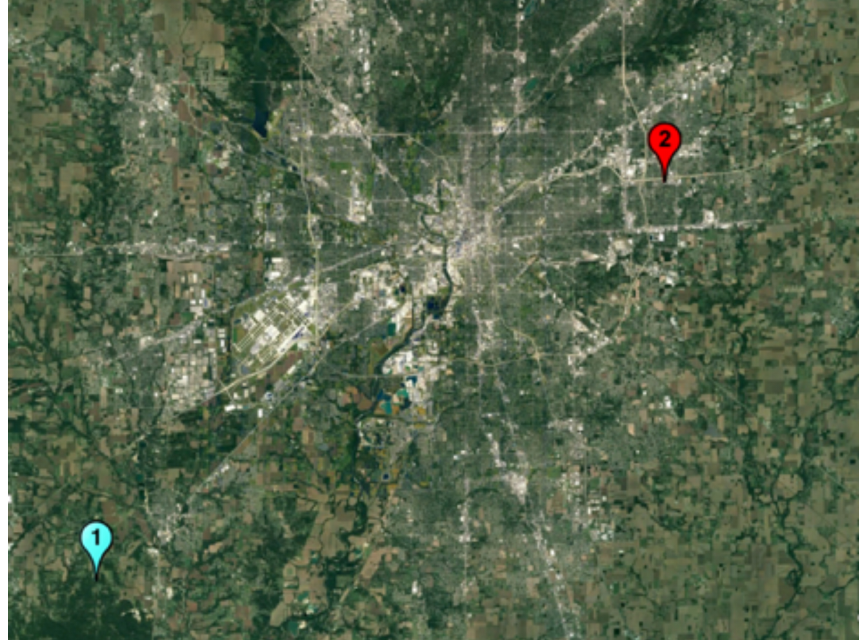
Figure 1. Satellite image (image created using Google Earth (© Google 2018)) of INFLUX tower locations. Arrow indicates predominant wind direction during sampling. Samples from this study were taken from towers 1 and 2 (shown). Also note the vegetation cover between the two